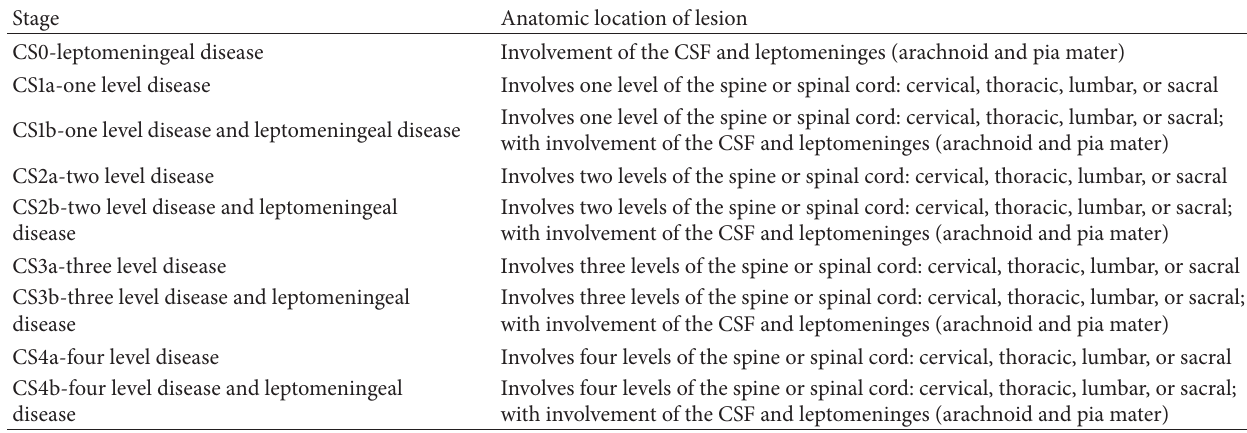
Table 1: Cedars-Sinai classification system for metastatic esthesioneuroblastoma to the spine.